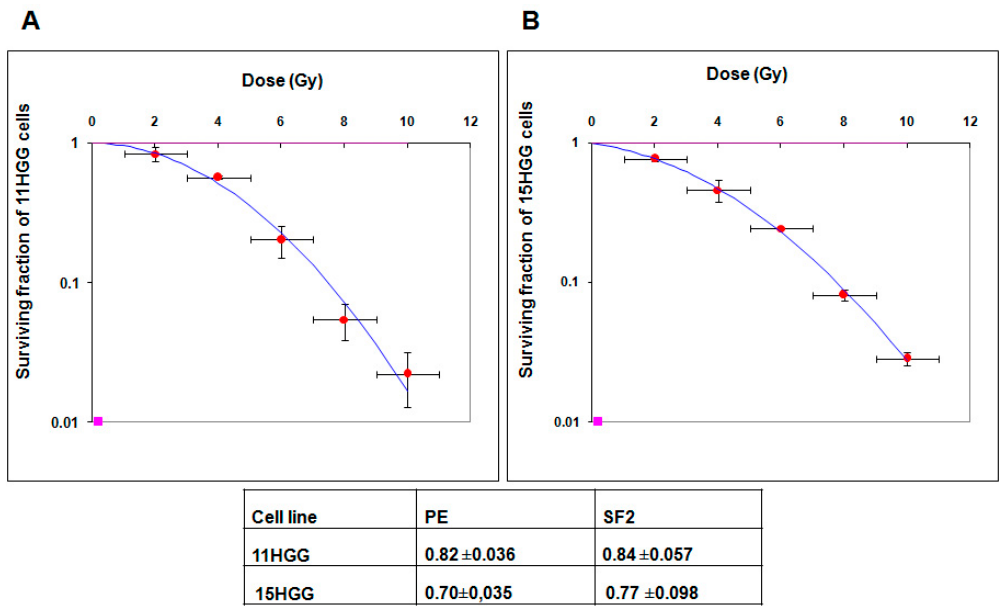
Figure 3. The e ff ect of γ -radiation on colony-forming ability in 11 HGG ( A ) and 15 HGG ( B ) cells. Cells were plated (100–7500 cells / 60-mm dish) and then were irradiated, using a 137 Cs source. Twelve days later colonies were fixed and stained with crystal violet. Colonies that contained more than 50 cells Int. J. Mol. Sci. 2019 , 20 , x FOR PEER REVIEW were counted. Data are mean and standard error of two separate experiments.